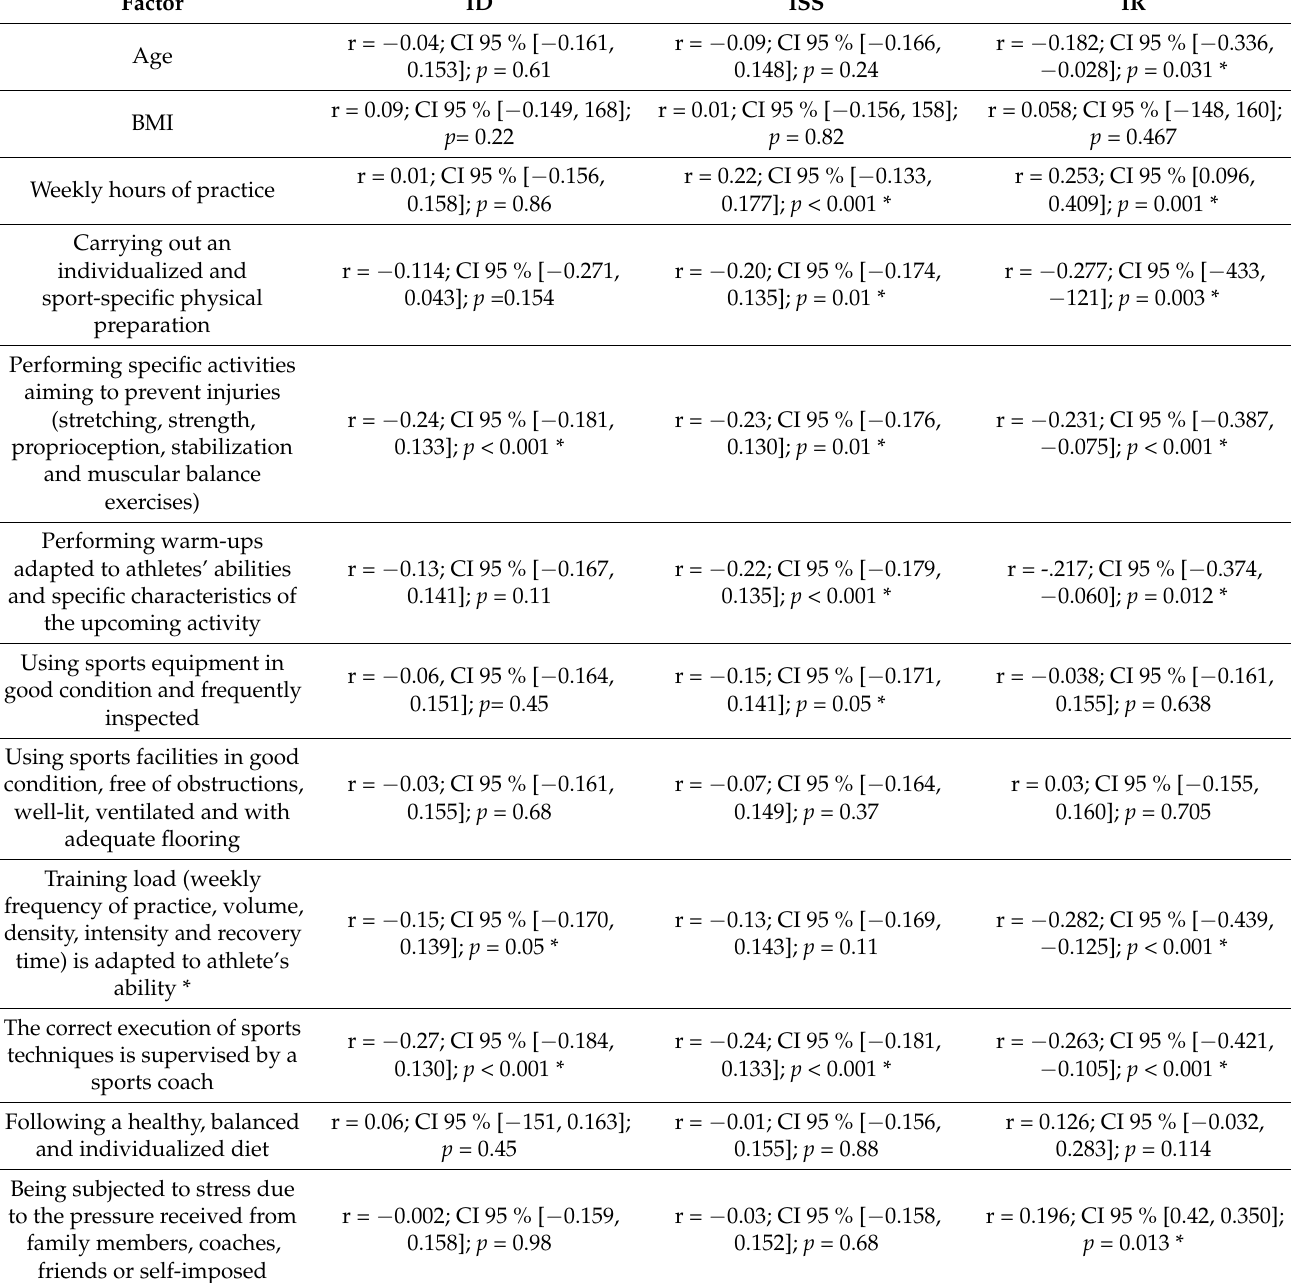
Table 4. Correlation between independent variables and ID, ISS, and